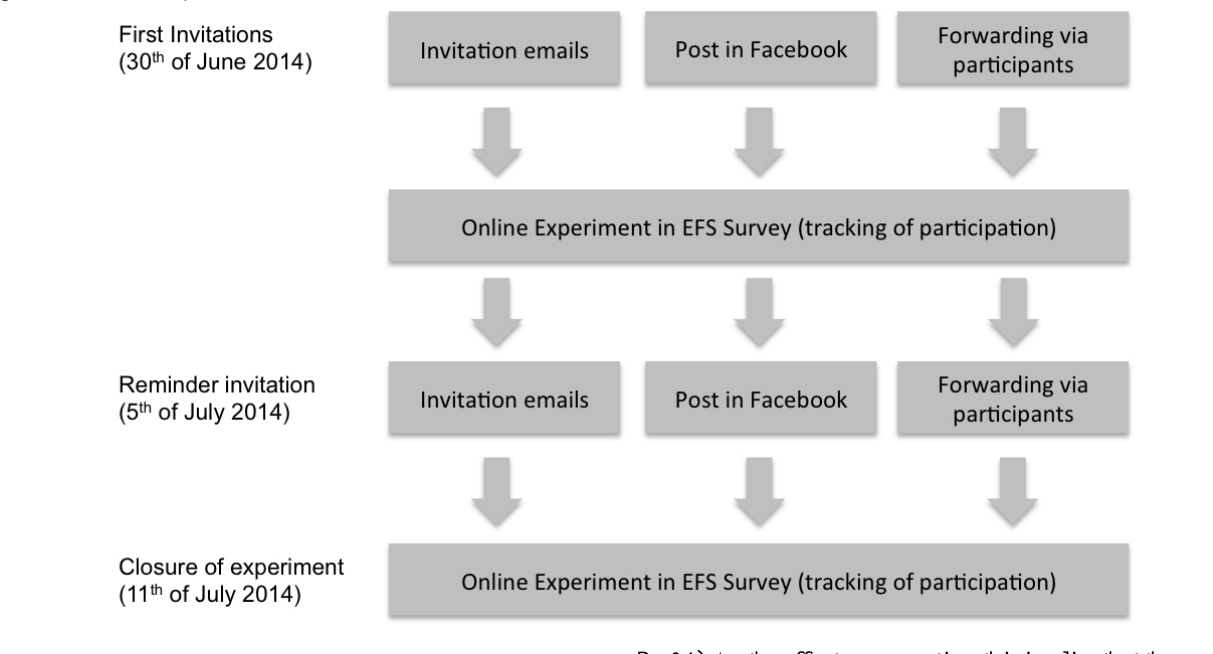
Figure 4. Recruitment